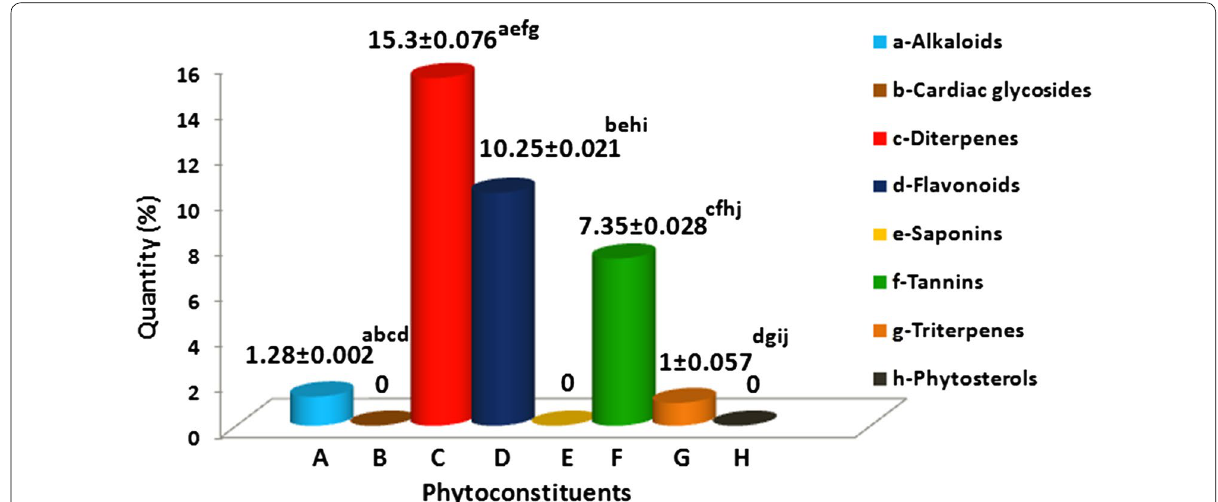
Fig. 1 The concentrations of various phytoconstituents of Berberis aristata root bark (%/g). *The values are expressed as mean **Same superscript alphabetic letters within the rows show significant statistical difference (p hoc Tukey’s t-test